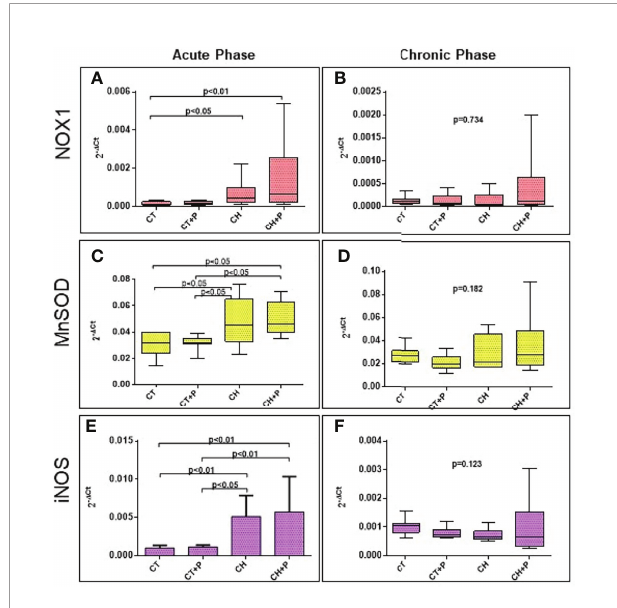
FIGURE 6 | Protein expression of in fl ammatory cytokines. (A) IL10 protein expression in the acute phase (n=5); (B) IL10 protein expression in the chronic phase (n=5). (C) IFN protein expression in the acute phase (n=5); (D) IFN protein expression in the chronic phase (n=5), (E) TNF protein expression in the acute phase (n=5); (F) TNF protein expression (n=5). in the chronic phase. CT - control group, CT+P – control group exposed to pollution, CH – chagasic group, CH+P – chagasic group exposed to